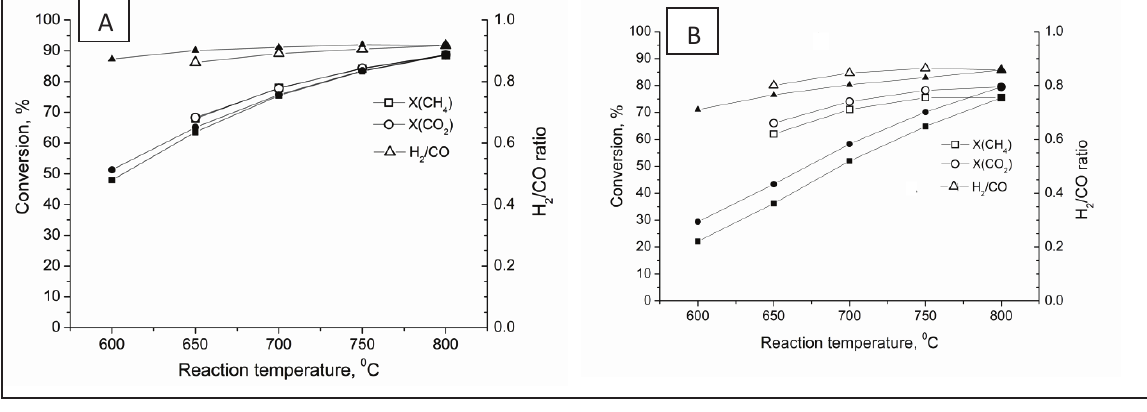
Figure 9: CH , CO conversion and H /CO ratio for Ni/Ch (A) and Ni/B2 (B) in direct (empty 4 2 2 , CO conversion and H /CO ratio for Ni/Ch (A) and Ni/B2 (B) in direct (empty symbols) and back (solid symbols) Figure 9: CH 4 2 2 symbols) and back (solid symbols) cycles.